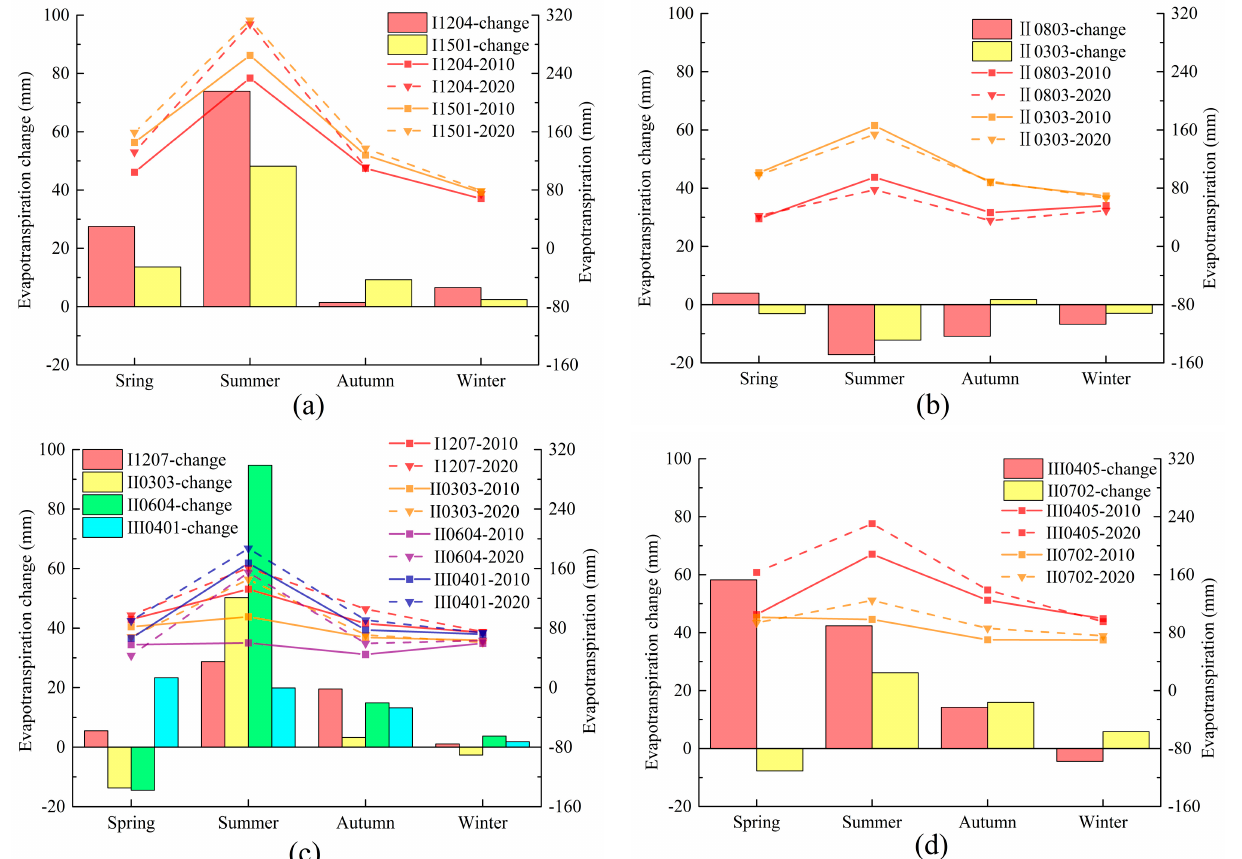
Figure 9. Seasonal variations in ET changes based on vegetation changes from 2010 to 2020. Conversion of ( a ) cultivated land into forest, ( b ) cultivated land into grassland, ( c ) grassland into cultivated land, and ( d ) grassland into forest.